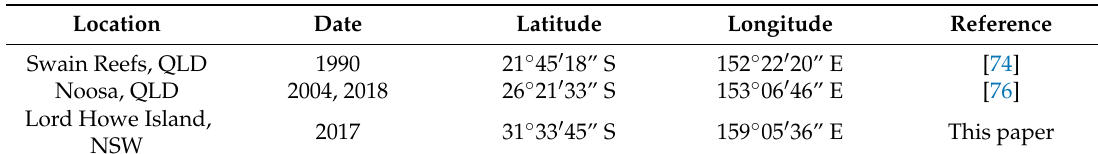
Table 7. Australian distribution records of Doriprismatica dendrobranchia . Table 10. Eastern Australian distribution records of Phestilla minor.